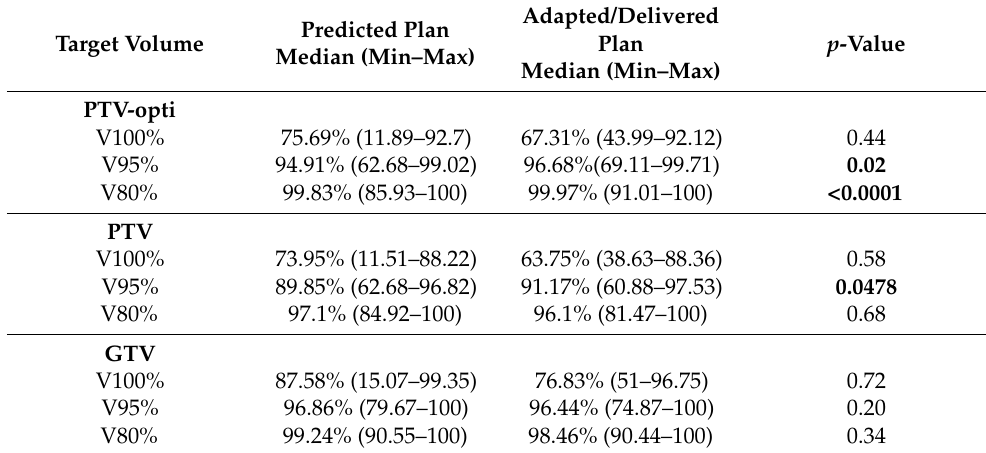
Table 4. Average target volume dosimetric results for the predicted and adapted/delivered plans.